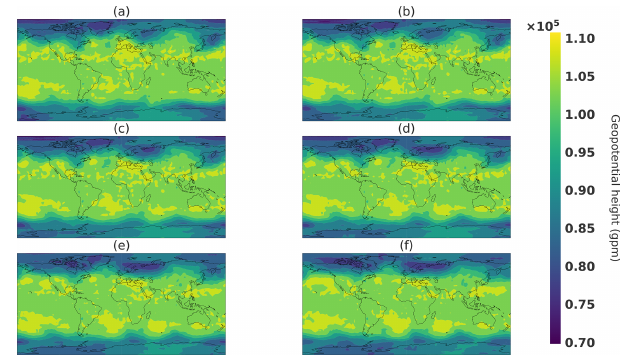
Figure 28. Linear interpolation in the image space. Respectively, panels (a–f) correspond to values of t in Eq. (19) of 0, 0.2, 0.4, 0.6, 0.8, and